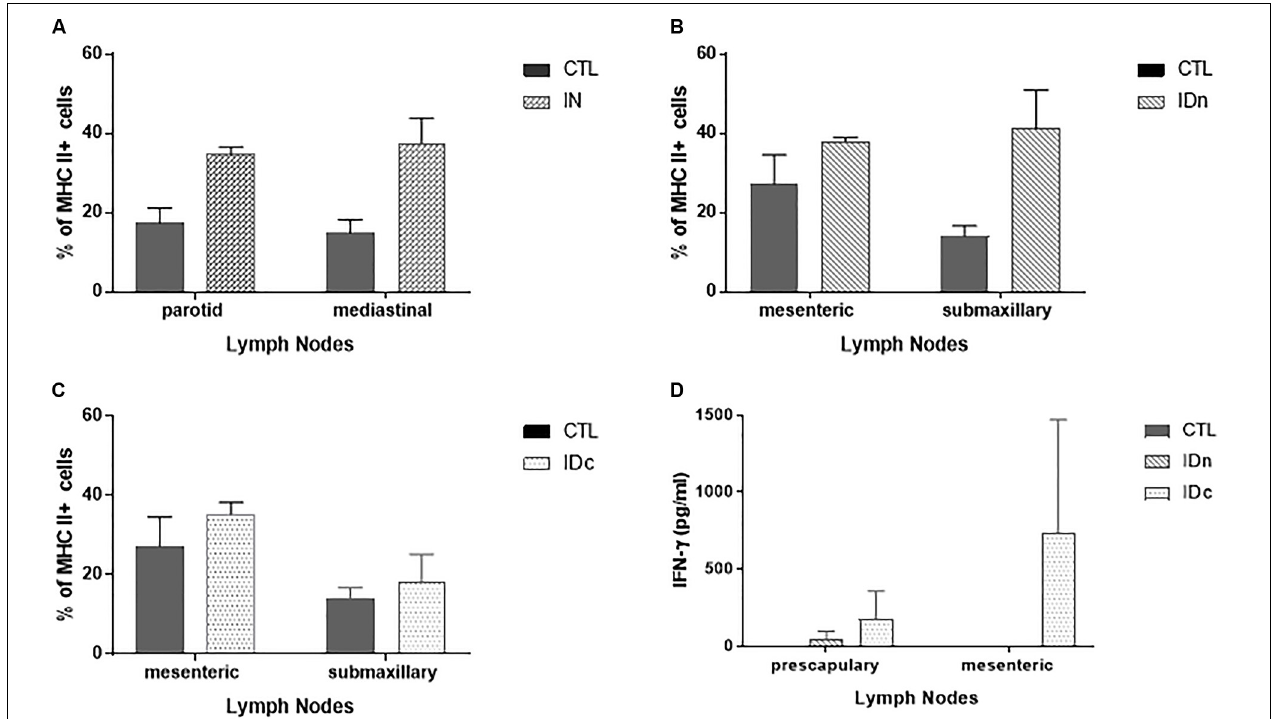
FIGURE 5 | Cellular immune response in draining lymph nodes of sheep (2 per group) 6 months after the last vaccination in the latent toxoplasmosis experiment. Data are expressed as mean ± SEM. (A) Expression of MHCII + cells among draining lymph nodes cells from intranasally immunized ewes (IN) compared to CTL. (B) Expression of MHCII + cells among draining lymph nodes cells from ewes vaccinated by intradermal route in the neck area (IDn) compared to CTL. (C) Expression of MHCII + cells among draining lymph nodes cells from ewes vaccinated by intradermal route in the cheek area (IDc) compared to CTL. (D) Specific IFN- γ secretion in draining lymph nodes from ewes vaccinated by both intradermal routes compared to CTL.